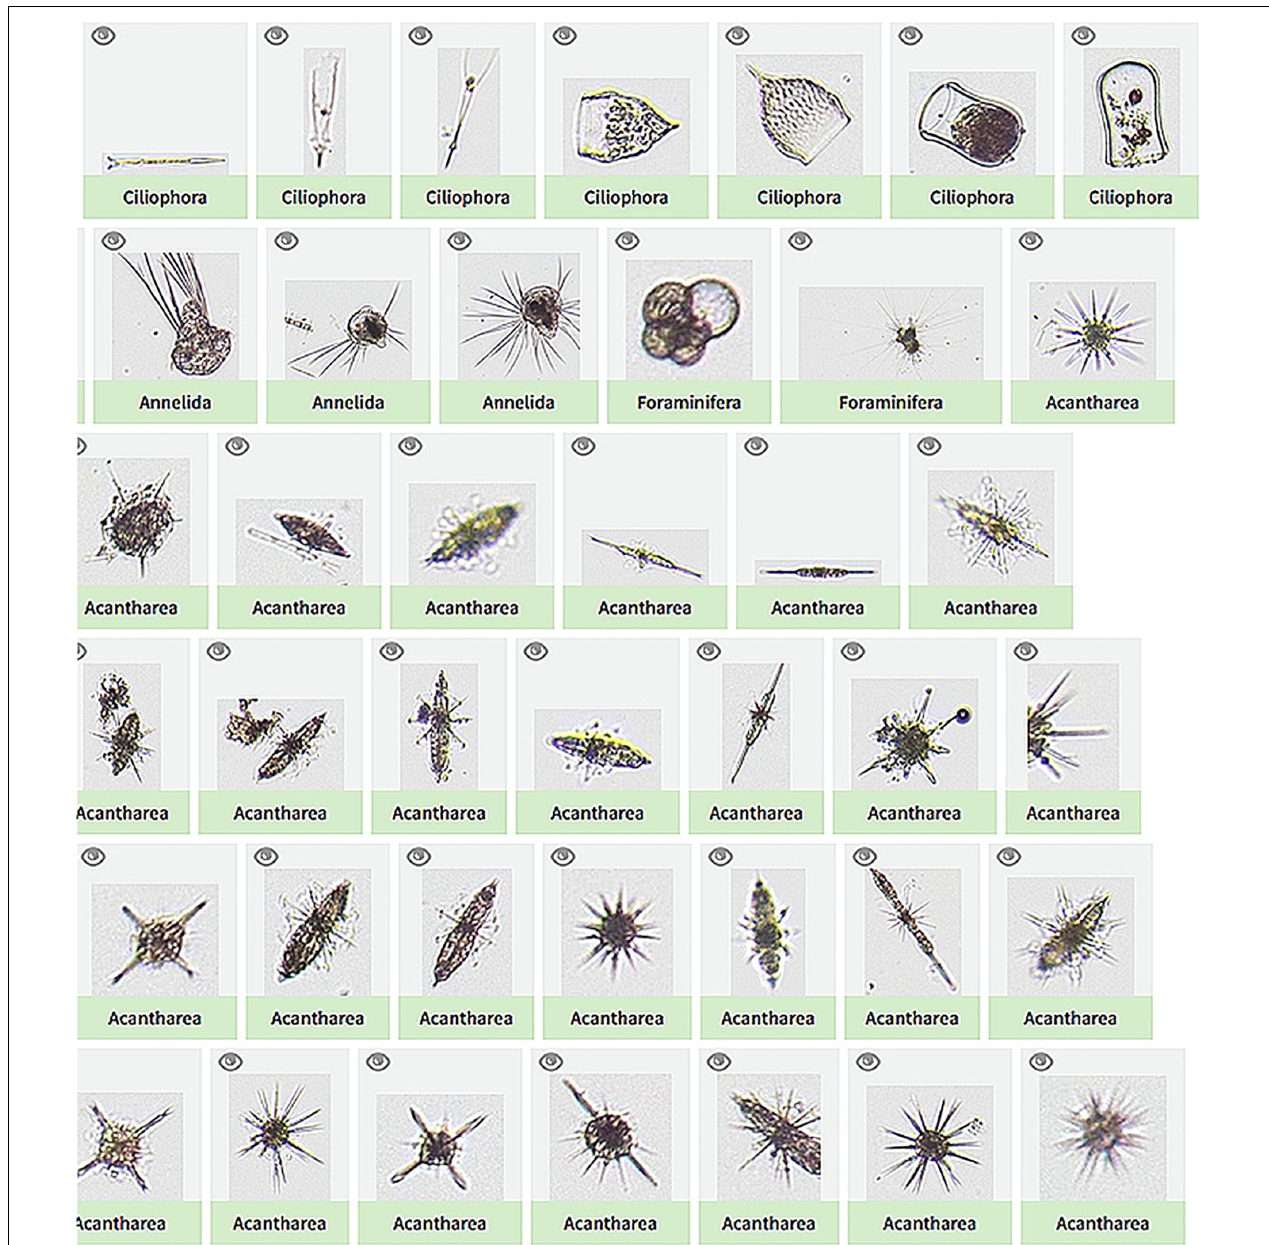
FIGURE 6 | Examples of Mediterranean microplankton imaged by PlanctonScope. PlanktonScope is an inexpensive imaging platform for citizen oceanography (Pollina et al., 2020) with a modular configuration based on do it yourself hardware and open software. The control of the instrument is possible from any device able to access a browser through a WiFi connection (Courtesy of EcoTaxa plankton imagedatabank;